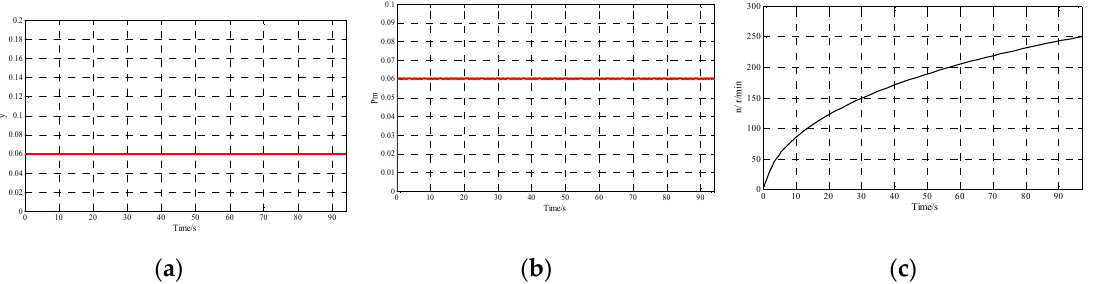
Figure 8. Waveforms of start-up in generating mode. ( a ) guide vane opening; ( b ) mechanical power; ( c ) speed.